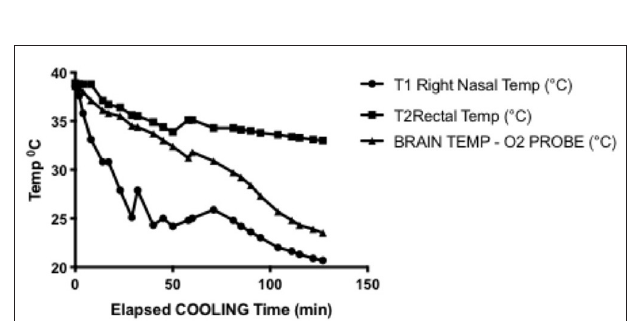
FIGURE 3 | Representative cooling curve for the brain temperature/oxygen measurement selective hypothermia experiment. Right nasal probe was ipsilateral to cooled hemisphere and was used in all experiments as a surrogate for brain temperature. Rectal temperature was core temperature and declines but to a manageable amount. Brain temperature measured through intraparenchymal probe placed in the left hemisphere, demonstrating moderate hypothermia is achieved in the contralateral hemisphere.